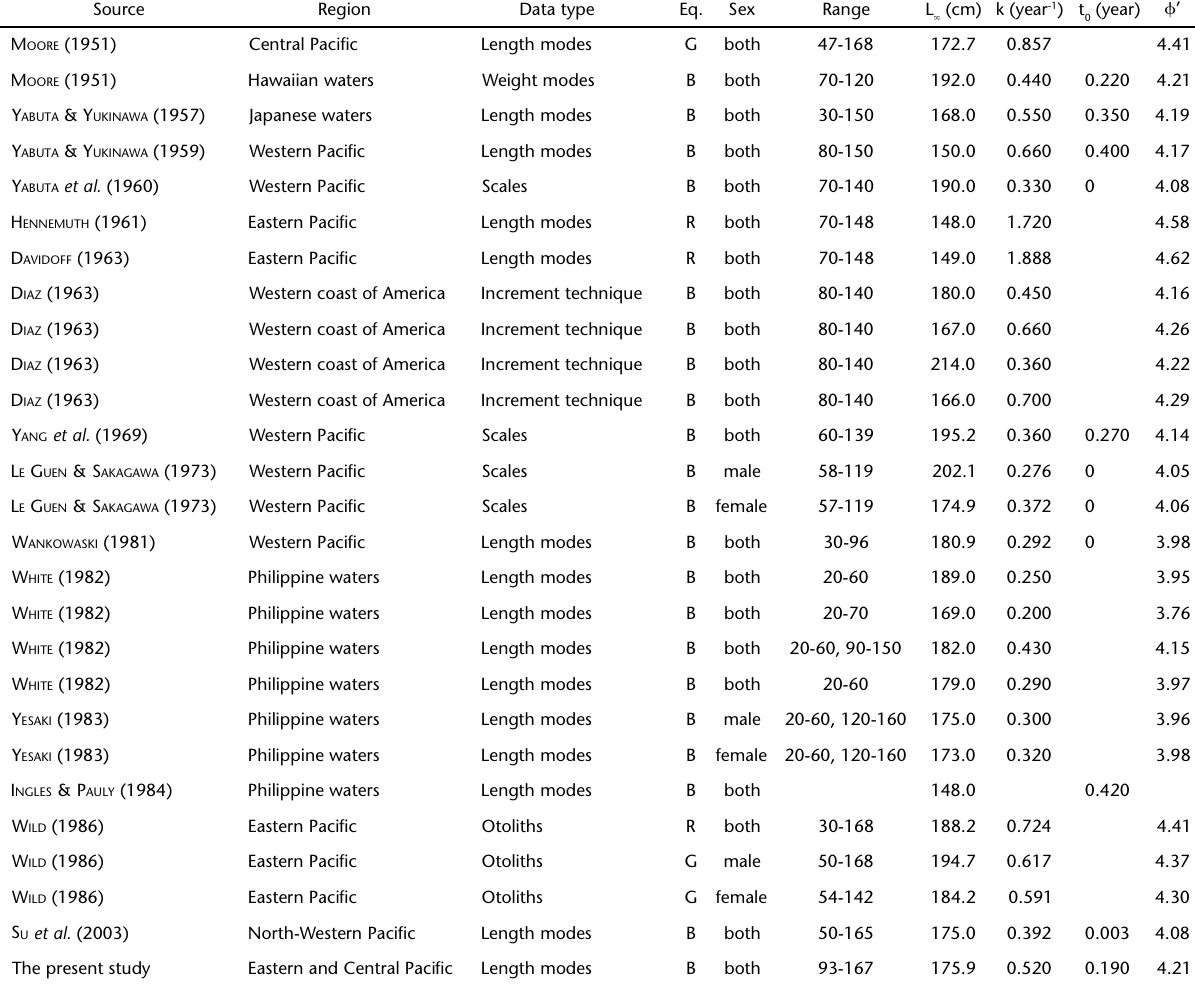
Table I. Comparison of growth parameters of yellowfin tuna reported by different authors and by date. Partly reproduced from table 1 of S UZUKI (1971), Table I of W ILD (1993) and table 2 of S UZUKI (1994). Eq. = equation, R = R ICHARDS (1959), G = G OMPERTZ (R ICKER 1979), B = VON B ERTALANFFY (1938),L (cid:2) = the asymptotic fork length, k = growth parameter, t 0 = the age at length